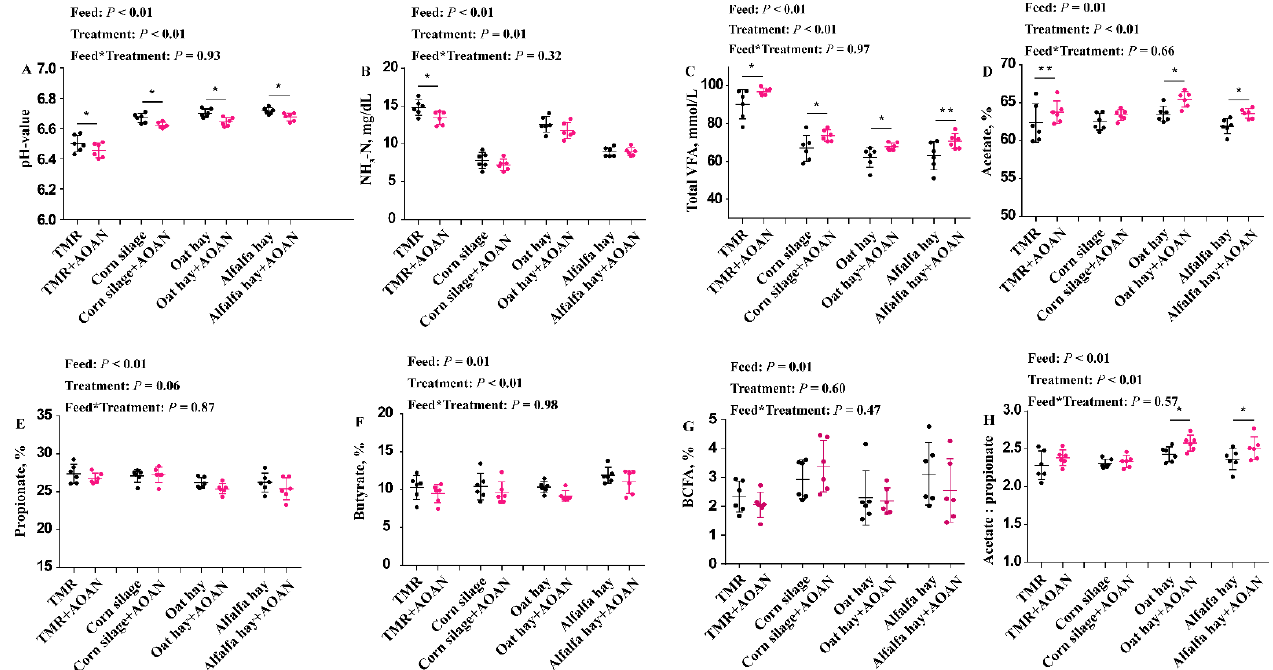
Figure 4. Effects of Aspergillus oryzae and Aspergillus niger co-cultivation fermentation extract on in vitro fermentation parameters (( A ): pH value; ( B ): NH 3 -N; ( C ): total volatile fatty acid; ( D – G ): individual VFA; ( H ): acetate: propionate) of total mixed ration, corn silage, oat hay, and alfalfa hay. AOAN indicates fermentation with Aspergillus oryzae and Aspergillus niger co-cultivation fermentation extract and individual VFAs are represented as molar proportions. *, p < 0.05; **, 0.05 < p < 0.10; TMR, total mixed ration; NH 3 -N, ammonia nitrogen; VFA, volatile fatty acid; BCFA, branched chain fatty acids (isobutyric + isovaleric).